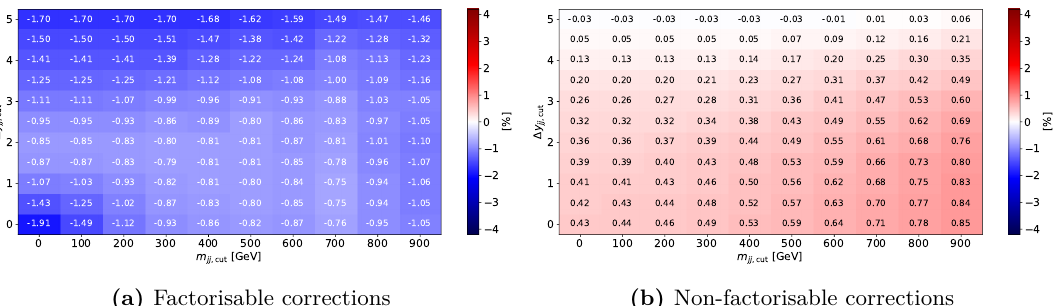
Figure 1. Replaces figure 2.